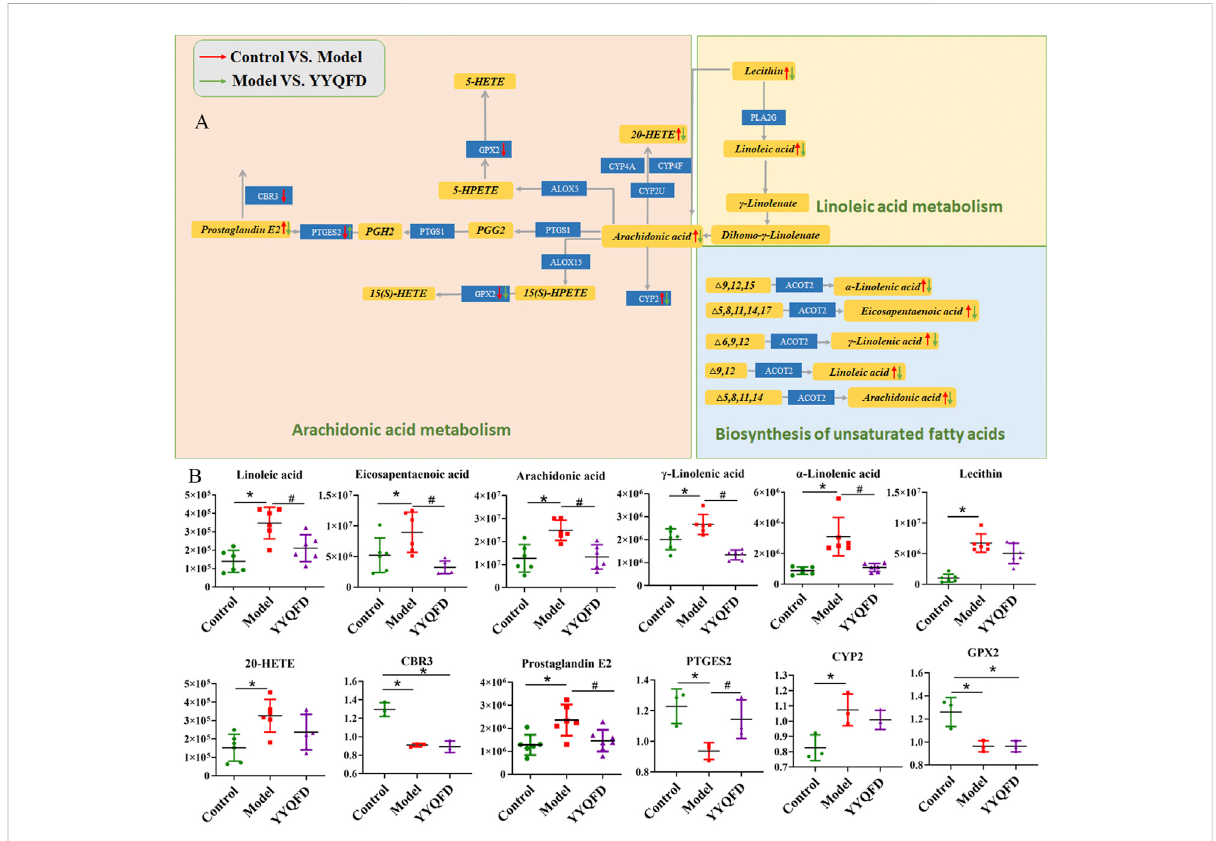
FIGURE 6 Arachidonic acid metabolism, linoleic acid metabolism and biosynthesis of unsaturated fatty acids pathways (A) and the content of signi fi cantly changed metabolites and proteins among the control, model and YYQFD group (B) .